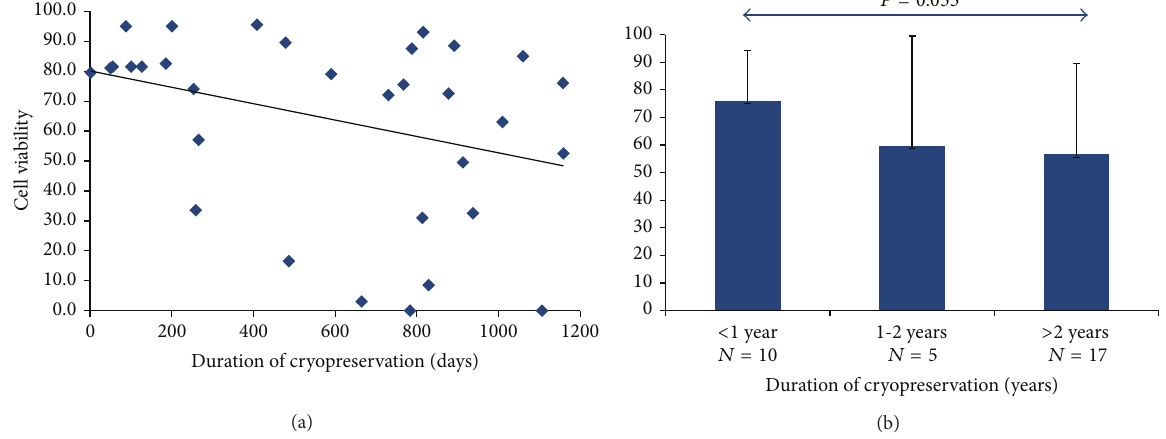
Figure 2: Initial ASC viability relative to cryopreservation duration. (a) A trend toward decreasing ASC viability with increasing ASC cryopreservation duration was observed. (b) ASC viability was compared relative to cryopreservation duration in 3 cohort groups: < 1 year ( 𝑁 = 10 ), 1-2 years ( 𝑁 = 5 ), and > 2 years ( 𝑁 = 17 ). No significant differences were observed between the three